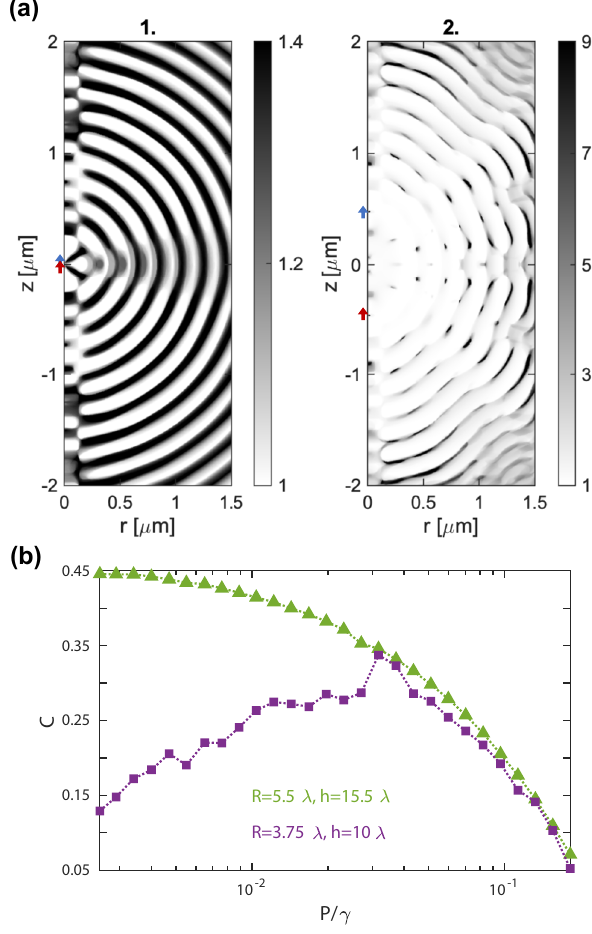
Figure 3: Dielectric cloaks and finite size effects. (a) Permittivity maps for the ID cloaks labeled as 1 (left) and 2 (right) in Figure 2(a). The dielectric constant is represented by white-to-black linear scales . (b) Concurrence versus pumping rate for devices with different 𝜖 max of two different sizes: R = 3.75 𝜆 and h = 10 𝜆 (purple) and R = 5.5 𝜆 = 2.85 𝜆 , and h = 15.5 𝜆 (green). Both set of cloaks operate at d 12 QE–QE distance indicated by the vertical black arrow in Figure